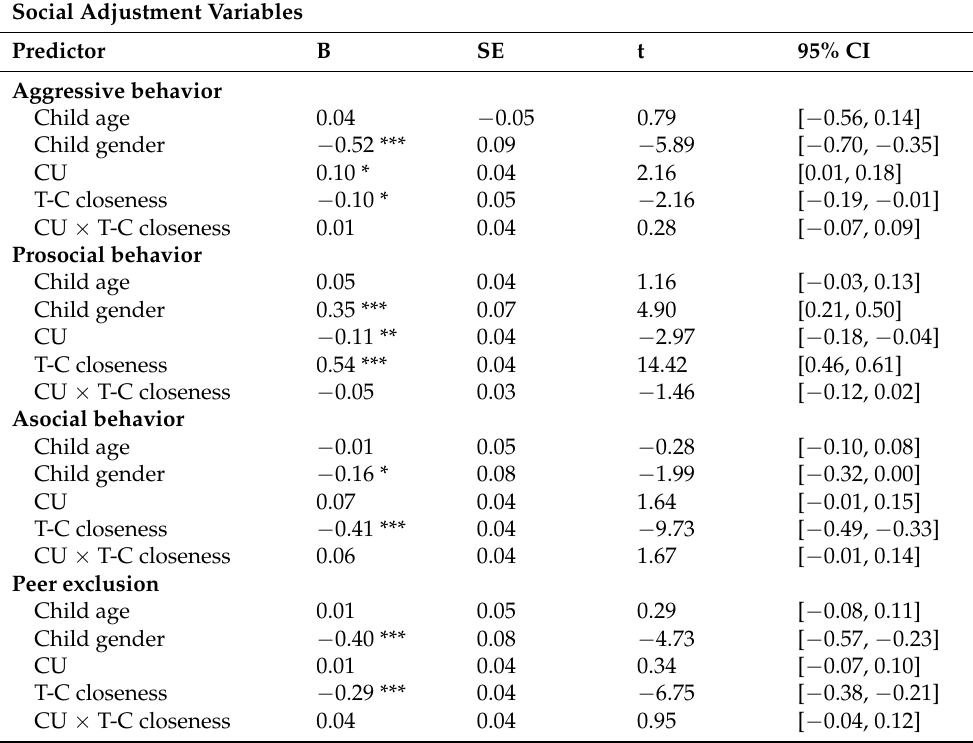
Table 3. Effects of CU traits, teacher-child closeness in relation to indices of social adjustment.